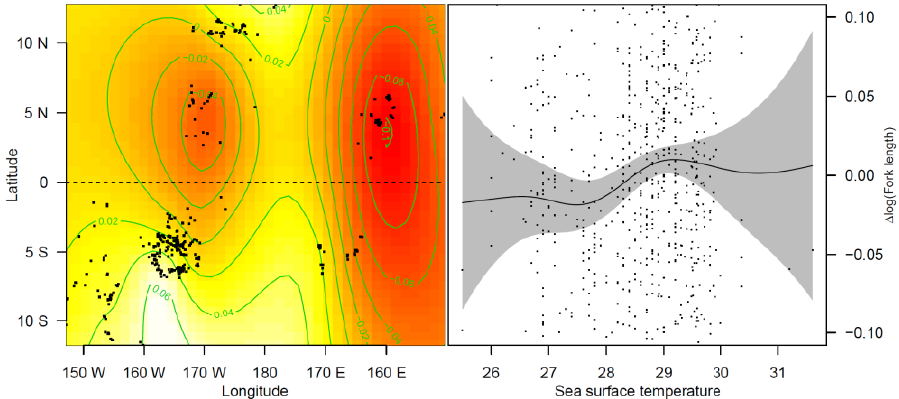
Figure 7. Effects of estimated environmental factors on the fork length in blue sharks in Pacific Ocean and location ( left ), and the effect of sea surface temperature on fork length ( right , Model 12). The colors in the left-hand panel represent the changes in log (fork length) from the average, where red denotes large negative changes and white indicates large positive changes. Black dots represent the data points and contour lines indicate the change in log (fork length). In the right-hand panel, the black solid line represents the relationship estimated by the model between SST and change in log (fork length), the grey area indicates the 95% confidence interval, and the black dots are the observations.